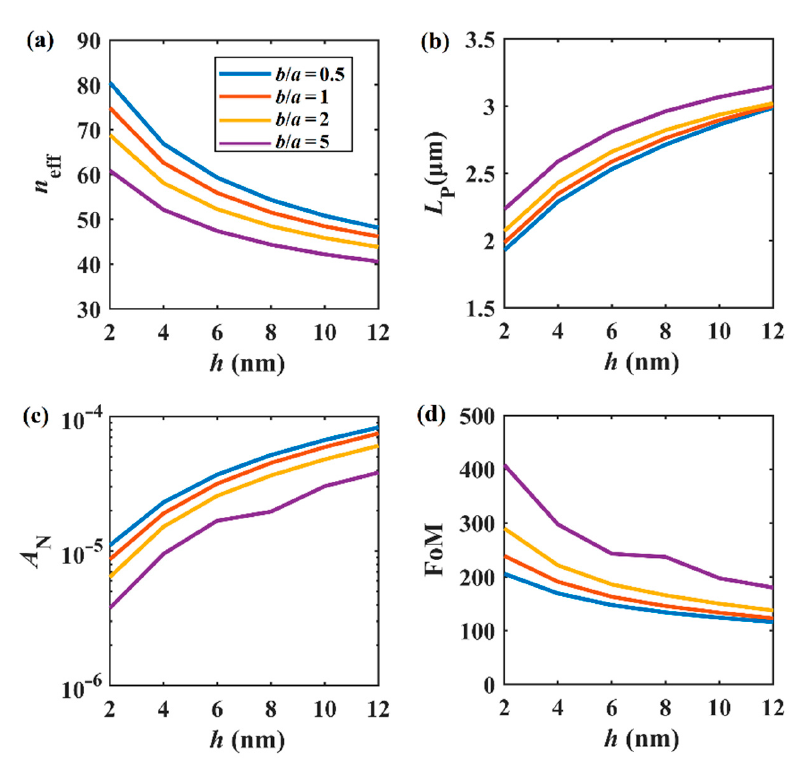
Figure 3. Modal properties of h at different b / a values. ( a ) n eff , ( b ) L P , ( c ) A N , ( d ) FoM. Based on above simulations, we show that the cases of b / a > 1 (orange and purple lines) show better performances compared with the cases of b / a = 1 (red lines) and 0.5 (blue lines) in terms of L P , A N , and FoM. In other words, these results show that the